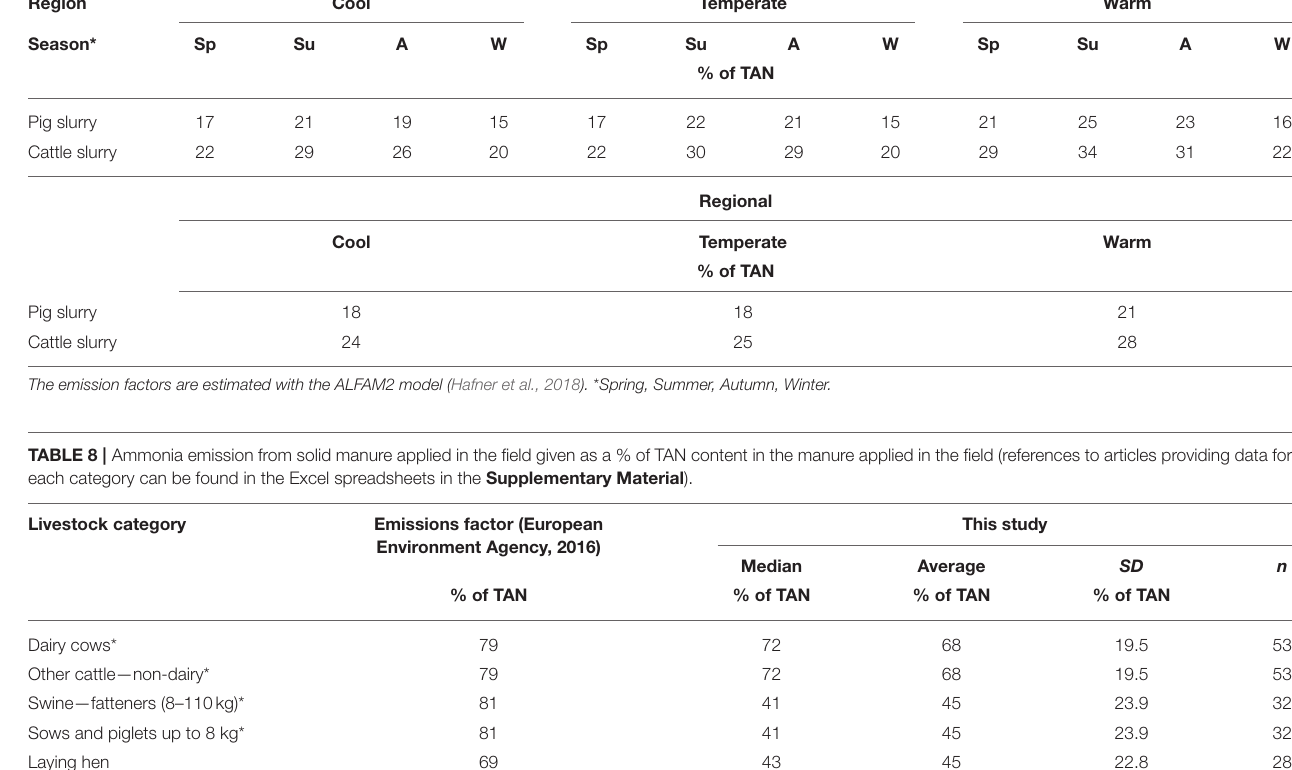
TABLE 7 | Ammonia emission from animal slurry applied in the field given as a % of TAN content in the manure applied in the field. Region Cool